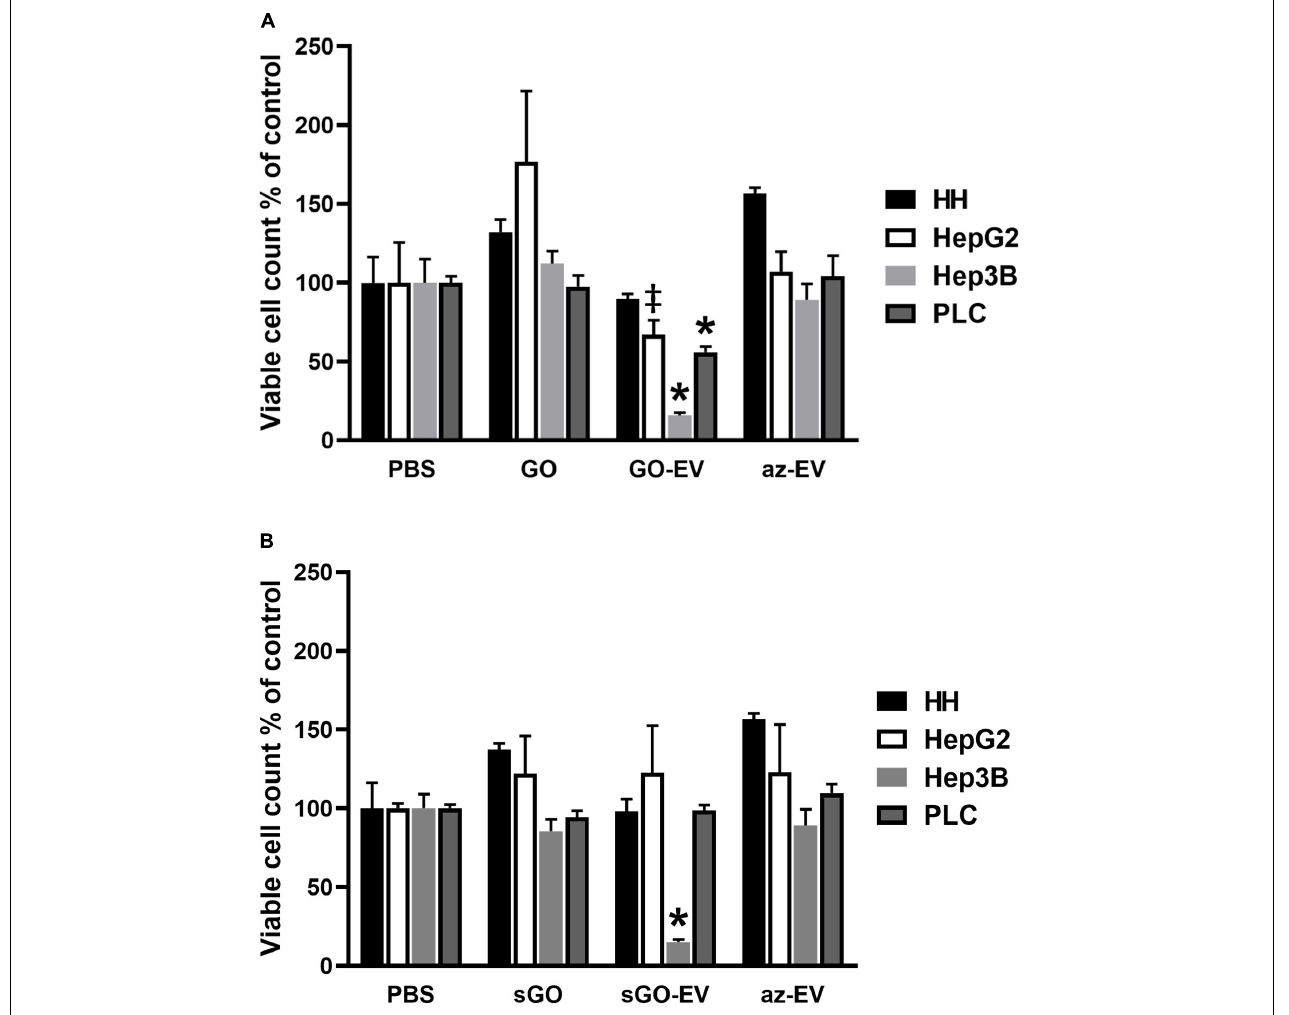
FIGURE 4 | C ytotoxicity of GO-EV and sGO-EV. Healthy human hepatocytes (HH) as well as three malignant hepatocyte cell lines (HepG2, Hep3B and PLC) were incubated with PBS, 4 µ g/ml GO, GO-EV, sGO, sGO-EV and az-EV. At 96 h post-treatment the viability of the cells treated with (A) GO- and (B) sGO-based biomaterials was evaluated by an MTS assay. The data represents the average ± SD. ‡ p < 0.05, ∗ p < 0.001 relative to PBS vehicle